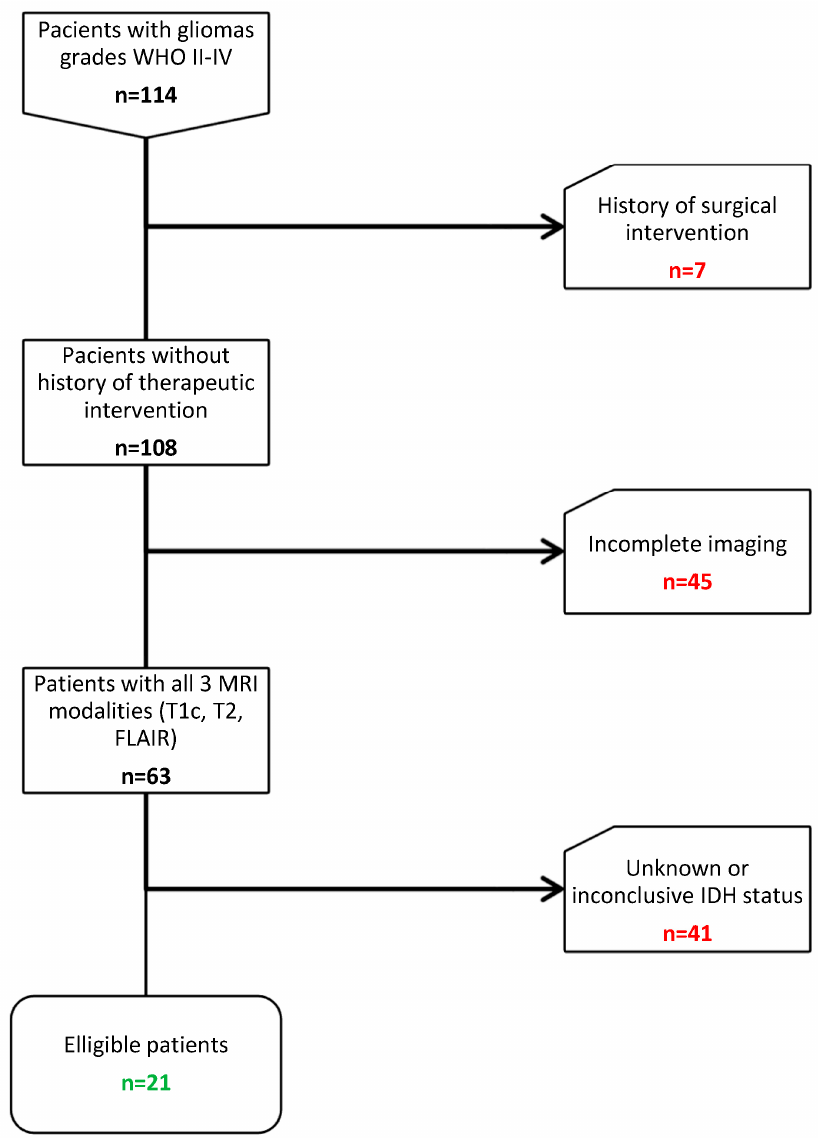
Figure 1. Sample selection diagram. Abbreviations: WHO, World Health Organization; MRI, magnetic resonance imaging; T1c, T1 contrast enhanced; FLAIR, fluid-attenuated inversion recovery; IDH, Isocitrate dehydrogenase.